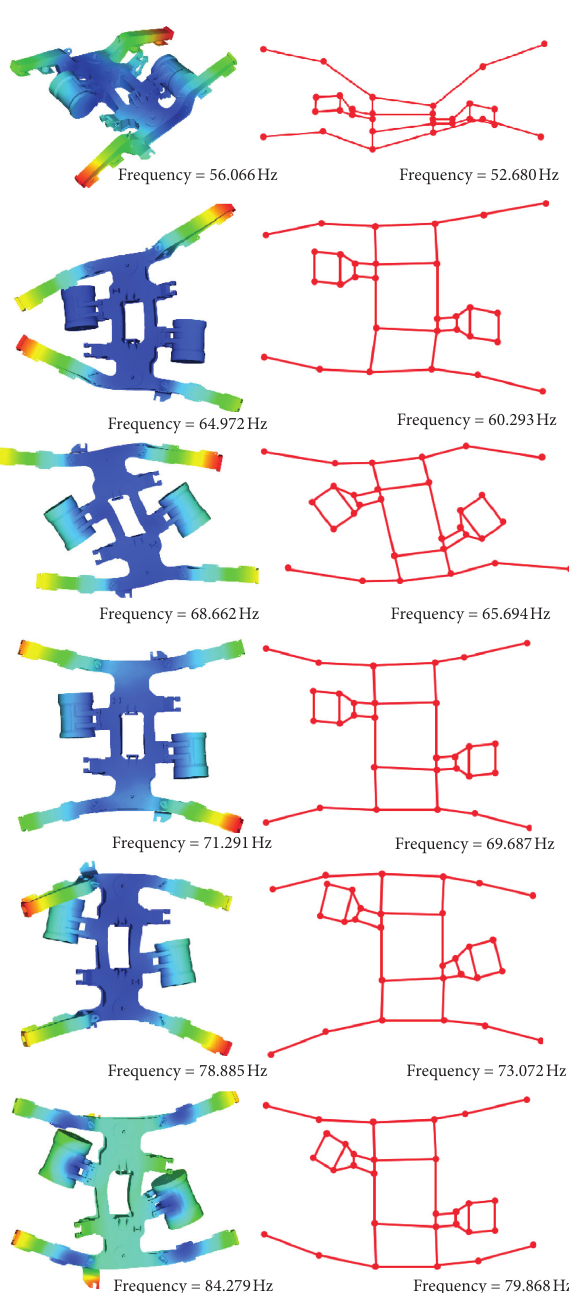
Figure 5: Comparison of modal shapes of FEM and EMA